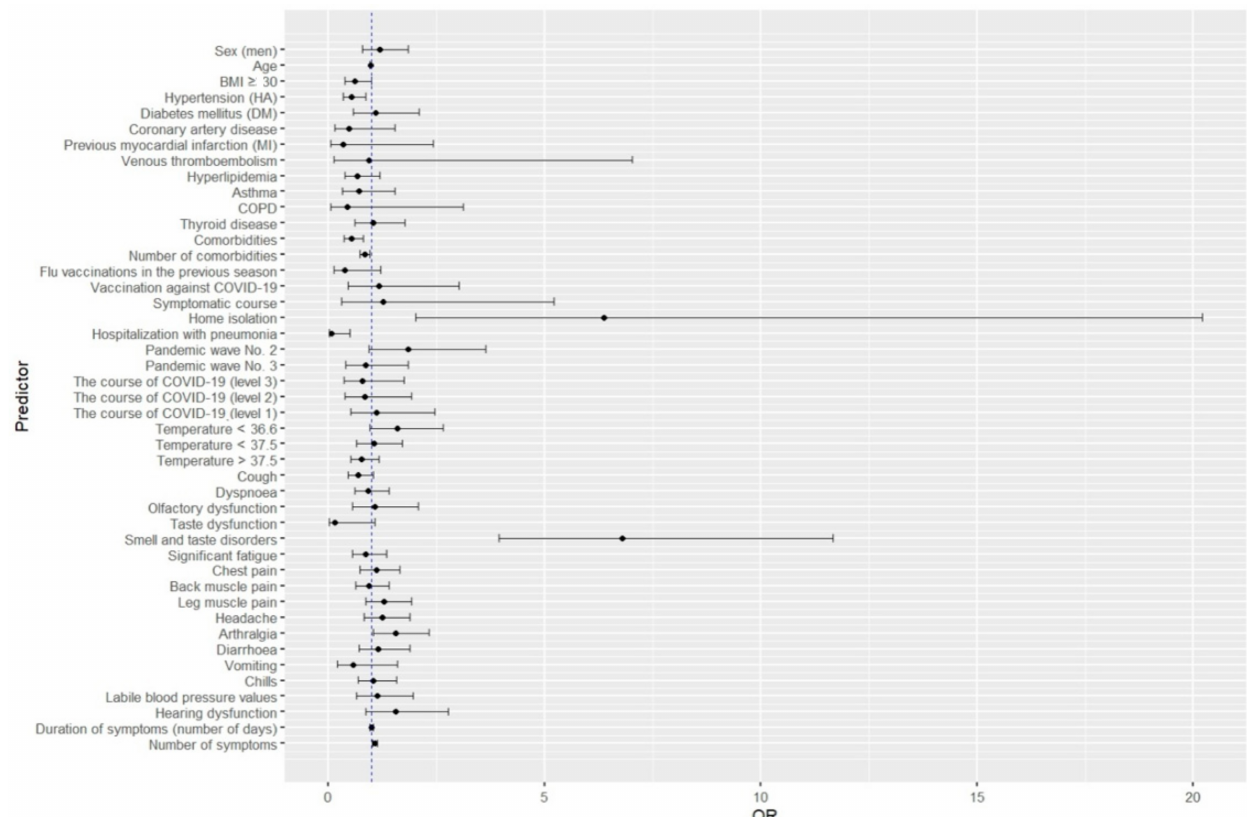
Figure 1. Graphical representation of univariate analysis determining the effect of sociodemographic variables, chronic diseases, influenza and COVID-19 vaccination and COVID-19 course on the risk of developing persistent smell and taste disorders.